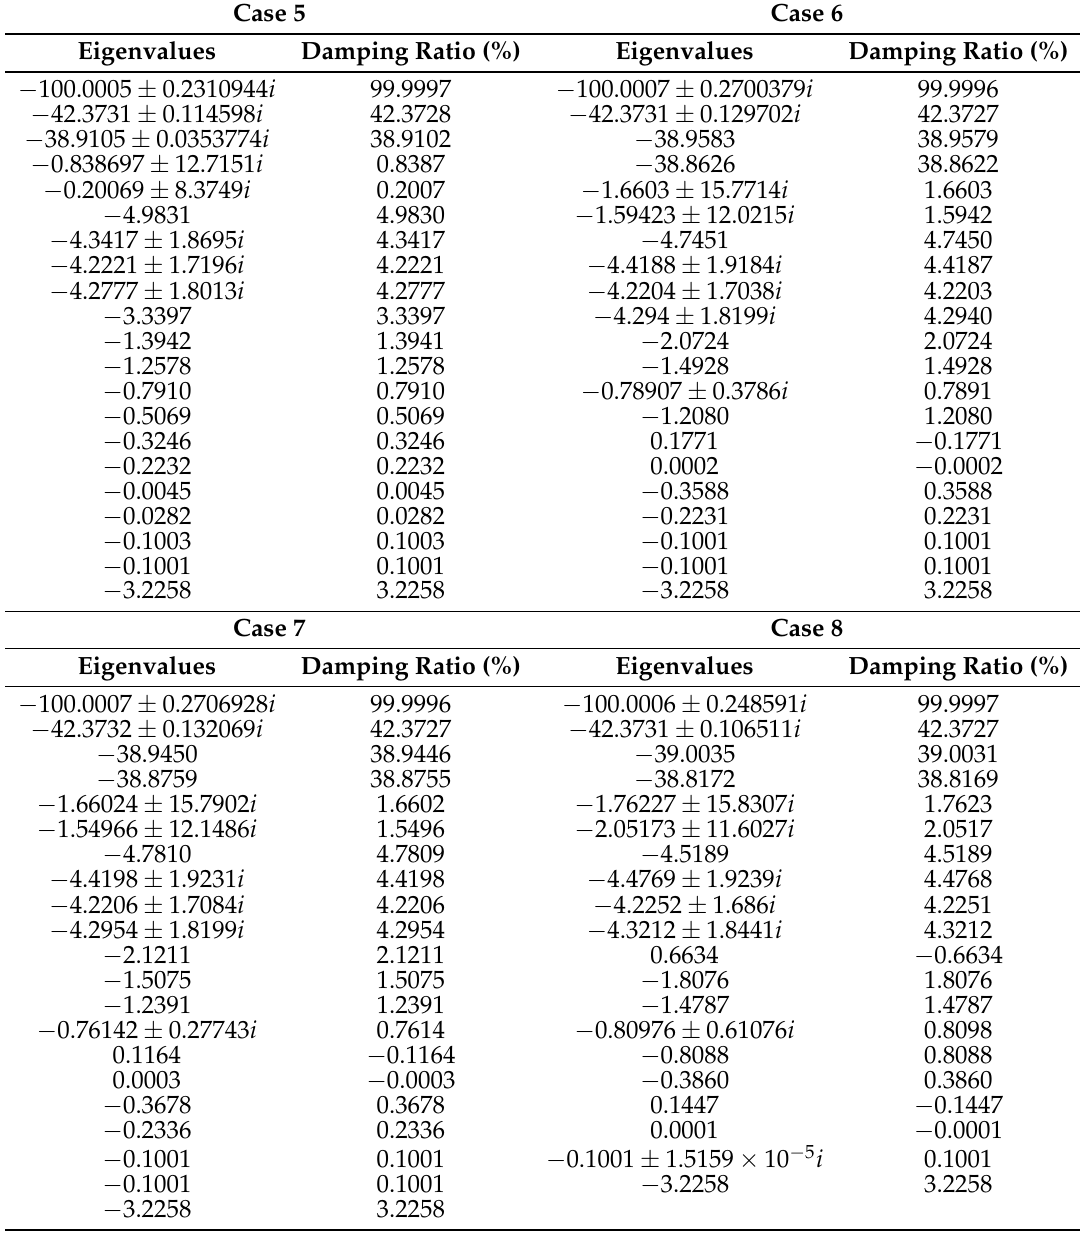
Table 6. Damping ratio percentages of Scenario